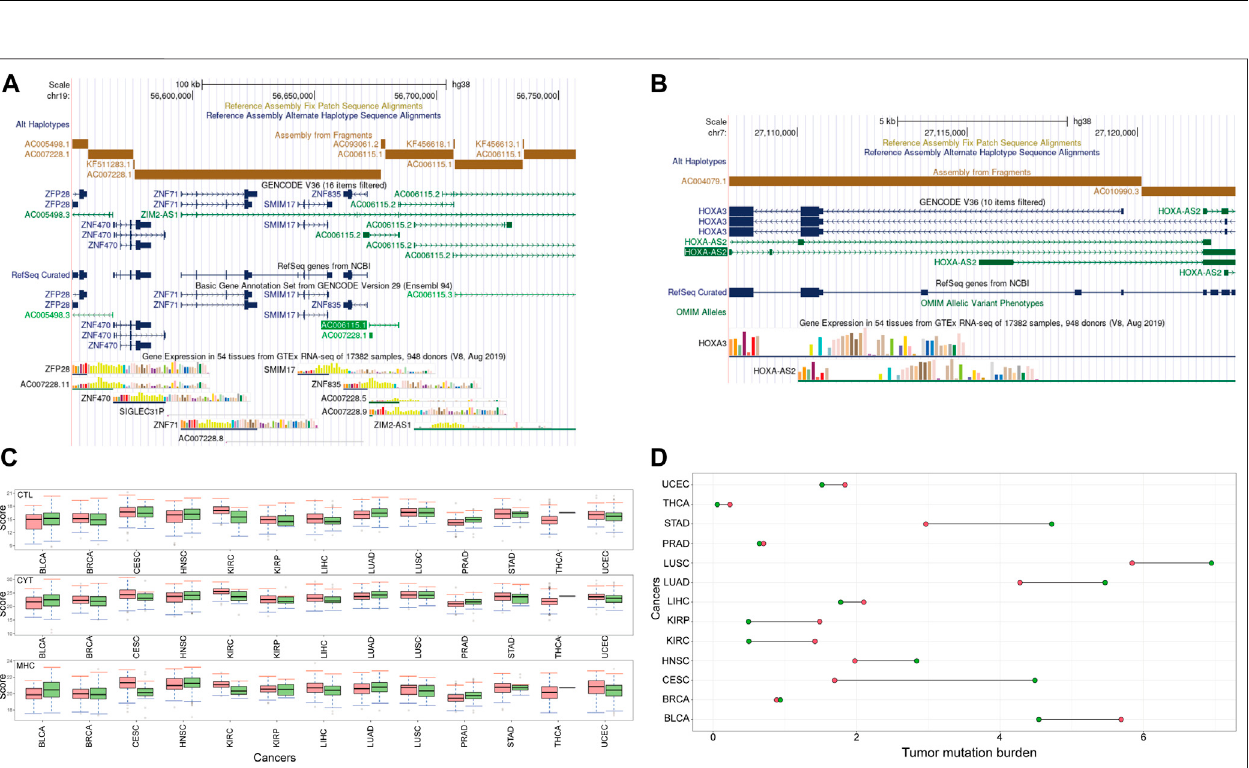
FIGURE 10 | The characteristics of HOXA-AS2 and AC007228 (A) The genomic location of AC007228 (B) The genomic location of HOXA-AS2 (C) Immune response scores of HOXA-AS2 and AC007228 (D) TMB of HOXA-AS2 and AC007228.